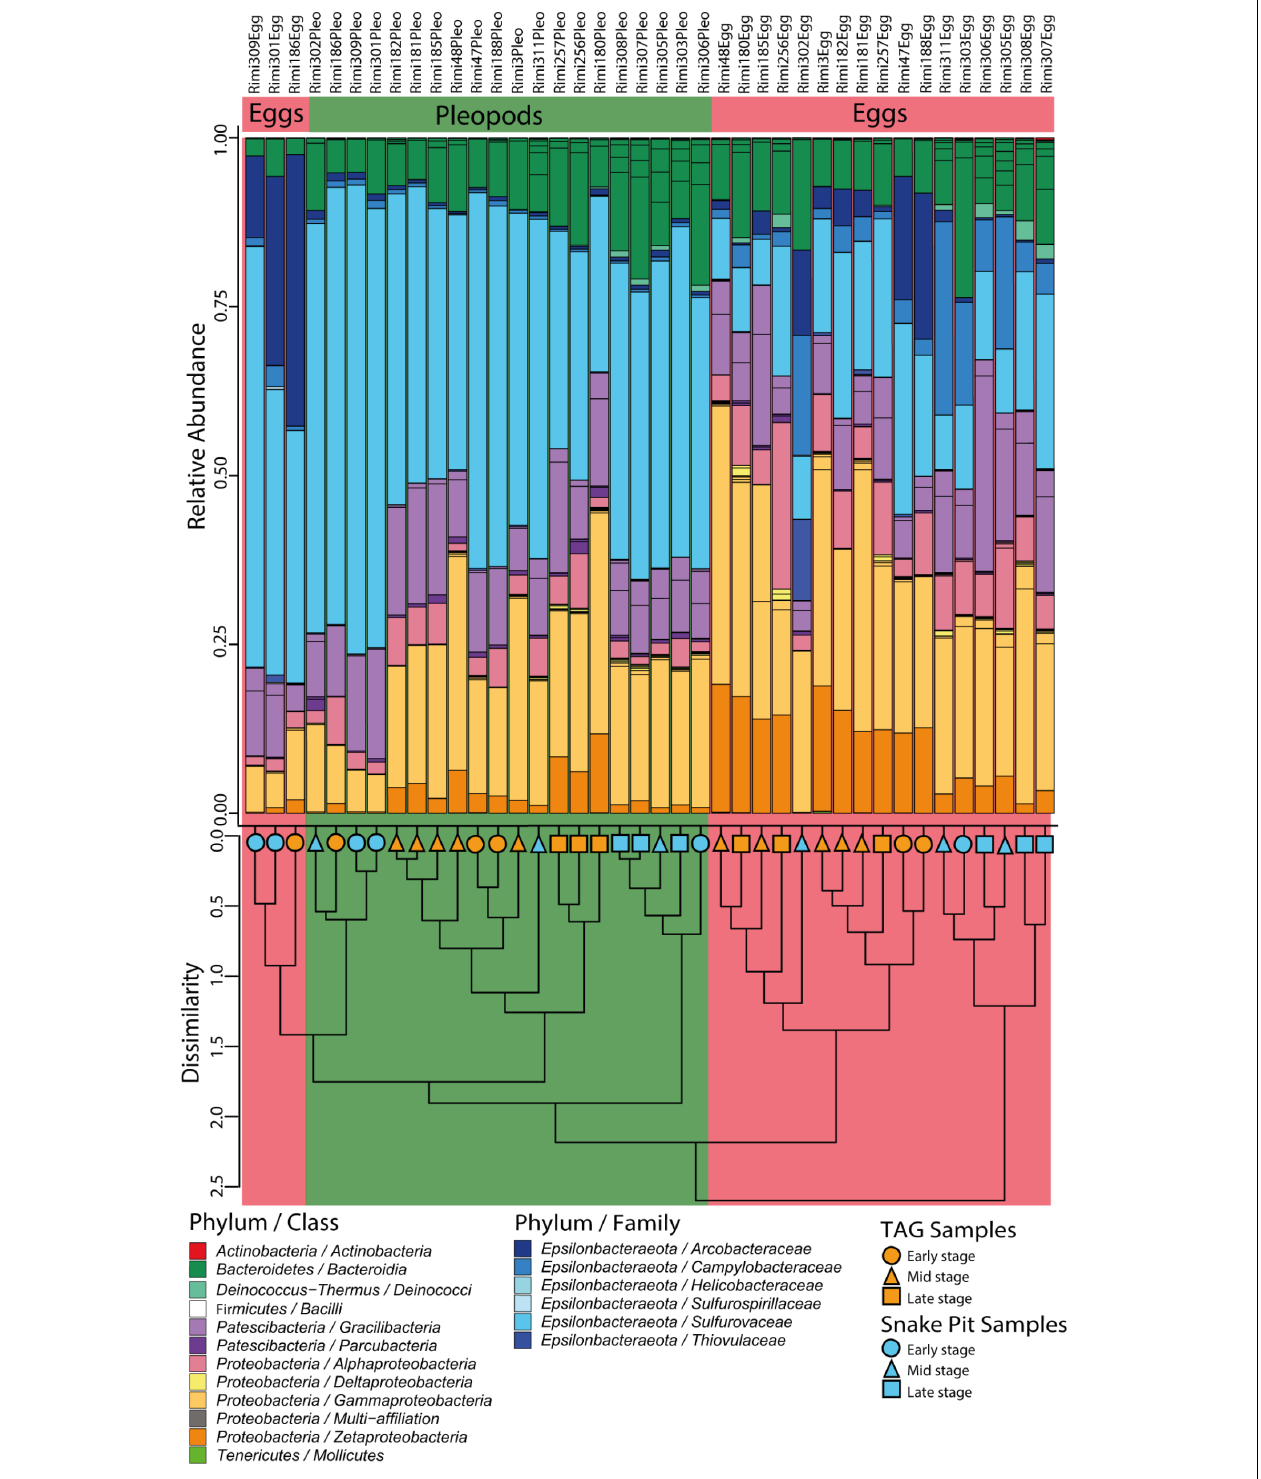
FIGURE 3 | Relative abundances of 16S rRNA gene sequence reads from egg and pleopod samples according to their classification (Silva 132 database). Groups are at the family level for the Epsilonbacteraeota phylum and at the class level for other phyla. The cluster dendrogram depicts the average linkage hierarchical clustering based on a Bray-Curtis dissimilarity matrix of community compositions resolved down to OTU level.